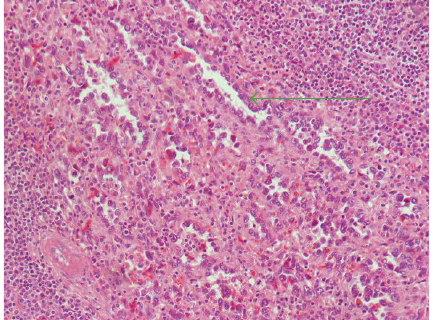
Figure 3: Microscopic image of the same lesion (H-E × 400), disorganizedanastomosingvascularchannelslinedbylarge,atypical endothelial cells (green